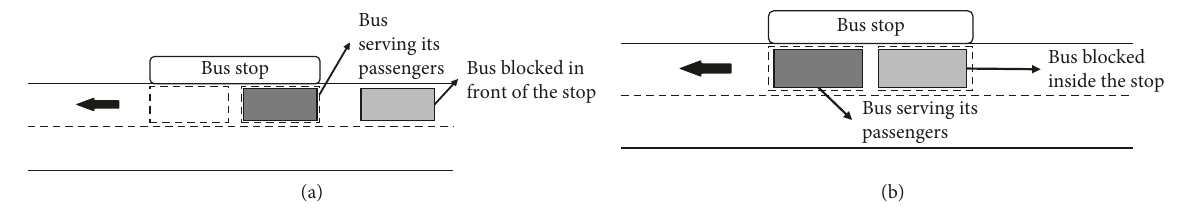
Figure 1: Mutual blockage situations: (a) in front of the stop and (b) inside the